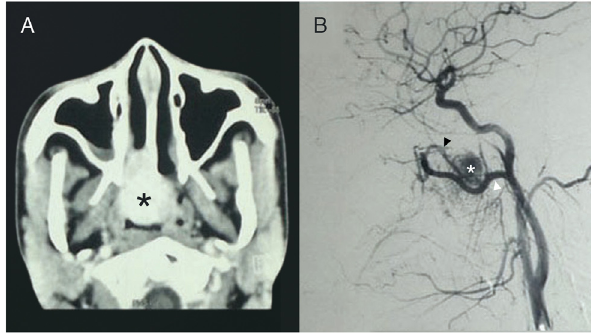
Figure 1. A . CECT Scan showing enhancing nasopharyngeal mass (asterisk) and B . Angiography showing vascular tumour (asterisk) supplied by sphenopalatine (black arrowhead) and internal maxillary (white arrowhead) arteries. Adobe Photoshop CC 20.01 release was used to erase identifying patient details, remove pixelated areas from black background, and enhance contrast to sharpen image (applied to entire